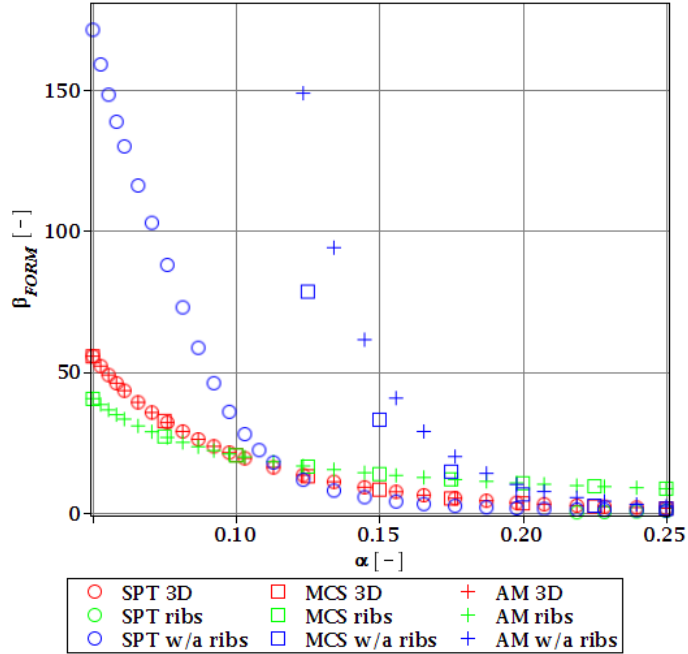
Figure 20. Reliability index of the corrugated I-beam for three ABAQUS models according to FORM and based on the eigenfrequencies.